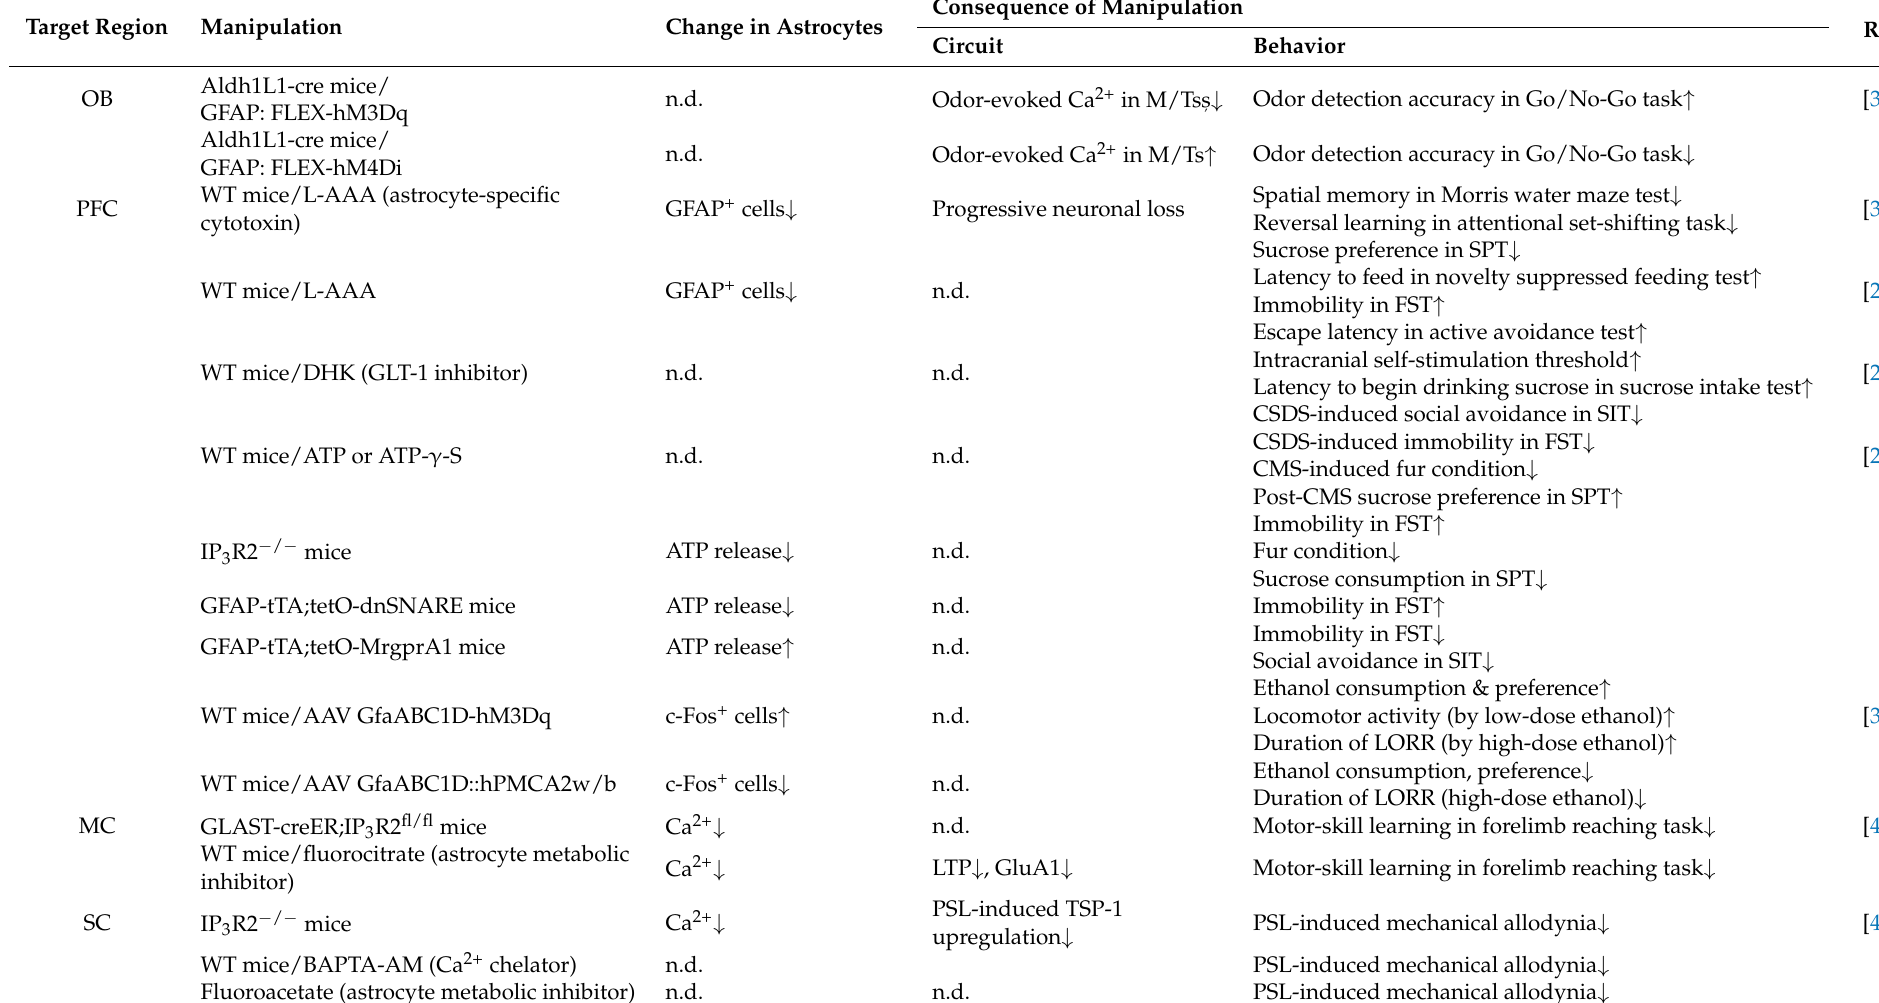
Table 1. Astrocyte-specific manipulation and its cellular and behavioral